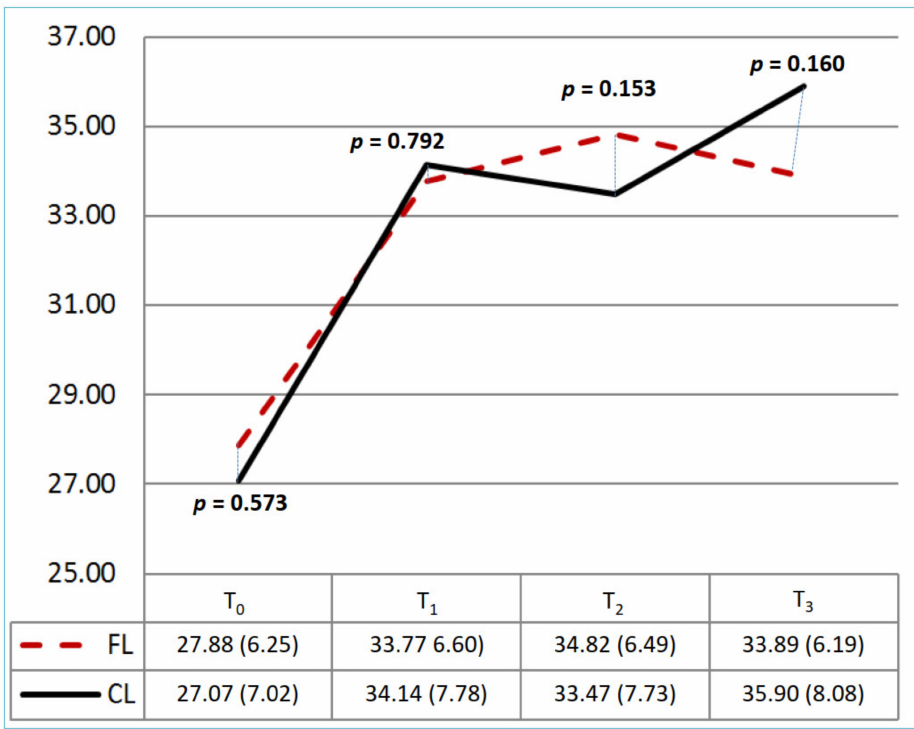
Figure 4. The change of practice score between groups at T 0 -T 3 . CL: conventional learning; FL: